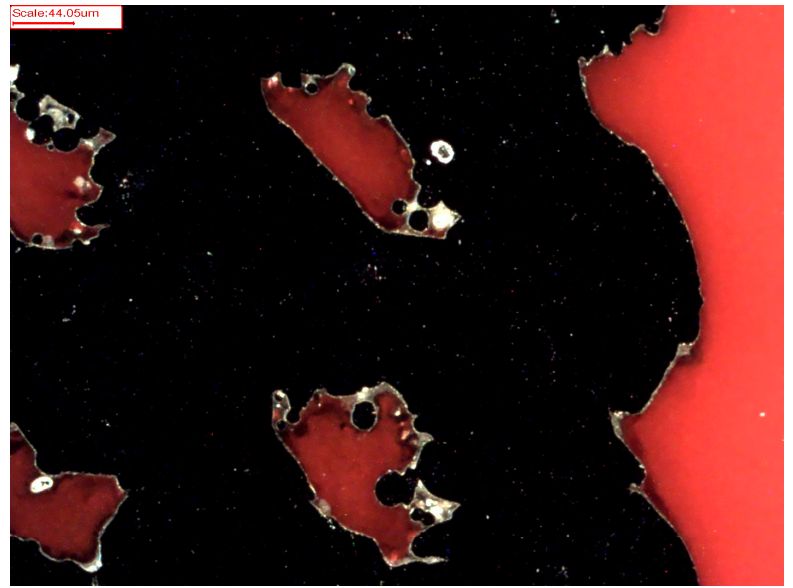
Figure 2. Exemplary micrograph image of a poly- ε -caprolactone (PCL)-coated titanium scaffold after cross-section preparation (black = titanium with pores; white rims = PCL coating; red = embedding medium; scale bar = 44.05 µm).